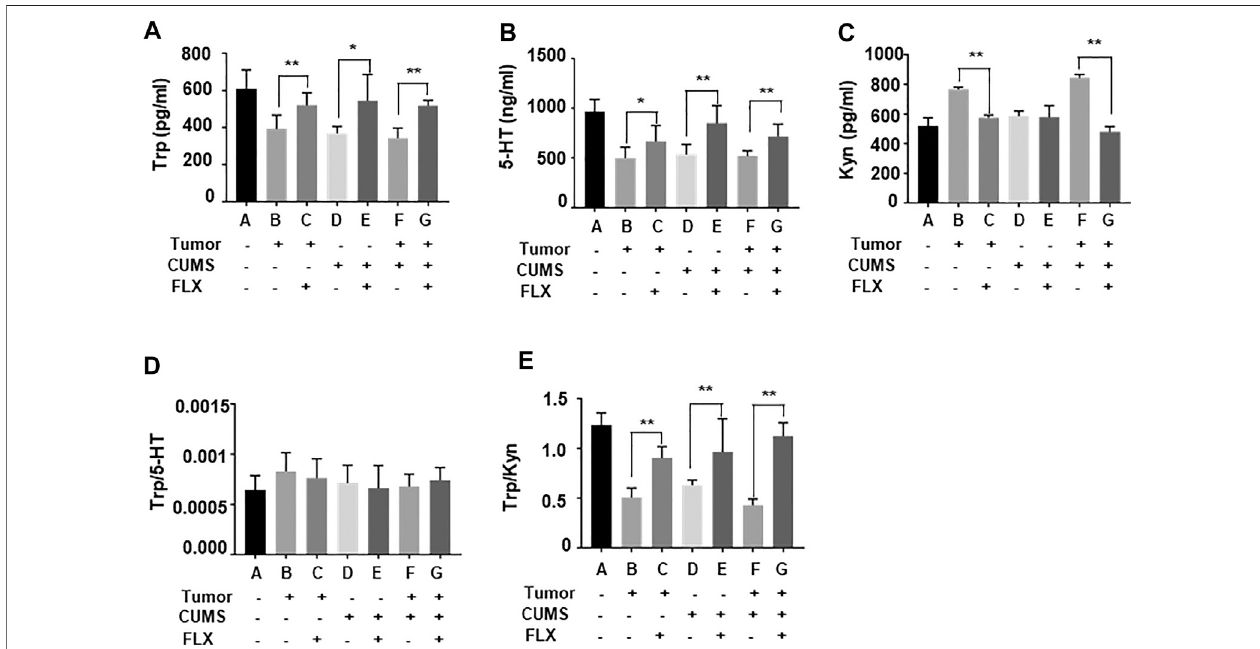
FIGURE4| Tryptophan (A) ,5-HT (B) ,kynurenine (C) , (D) Trp/5-HTand (E) Trp/kynbloodlevelsinmice.Datawereexpressedasmean ± SD.* p < 0.05,** p < 0.01.